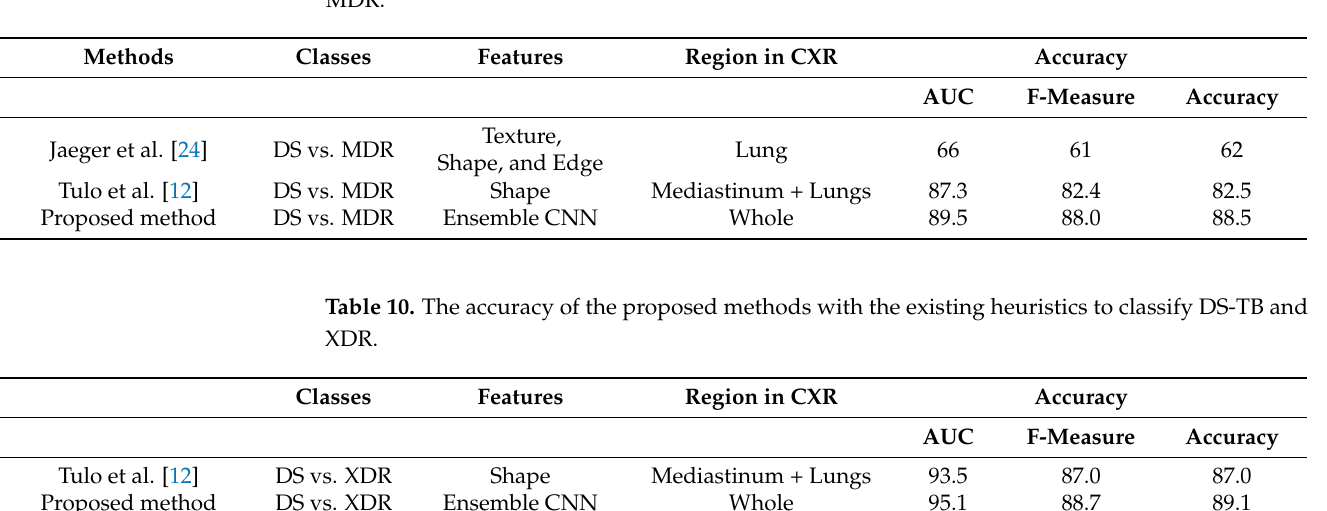
Table 9. The accuracy of the proposed methods with the existing heuristics to classify DS-TB and MDR.